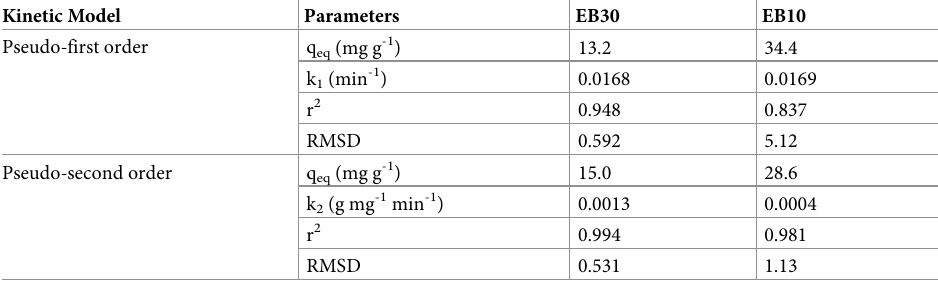
Table 1. Kinetic parameters for copper biosorption by EB30 and EB10. Conditions: Initial copper concentra- tion = 100 mg L -1 ; pH i = 5 ± 0.1; agitation speed = 150 rpm; temperature = 25 ± 2˚C; biosorbent dosage